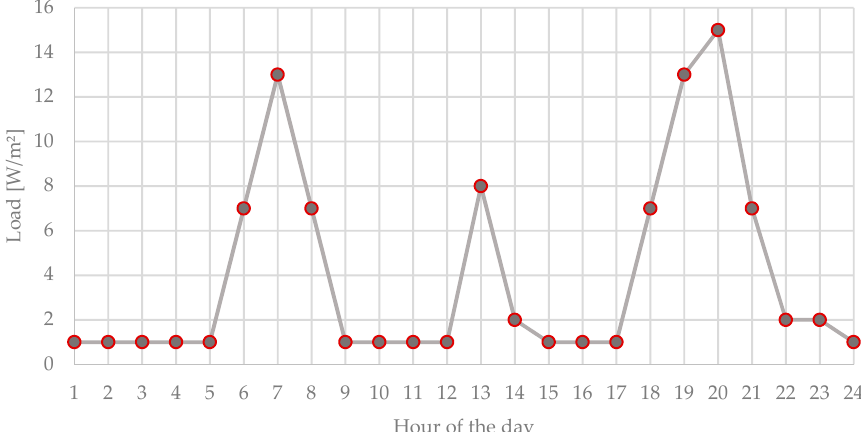
Figure 5. Internal gains daily profile.